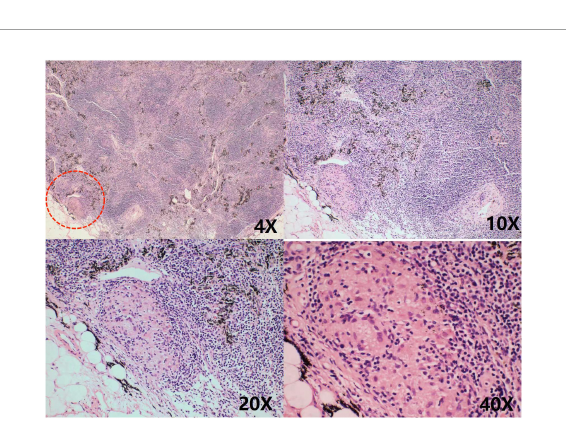
FIGURE4 Chronic inflammatory cell infiltration was seen in the connective tissue granulomatous lesions and fibrous tissue hyperplasia were seen in the lymph nodes No necrosis was observed. As shown in the red circle.